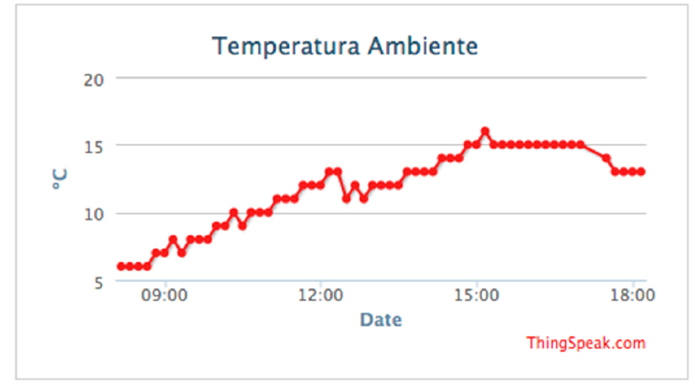
Figure 9. Temperature change graph.